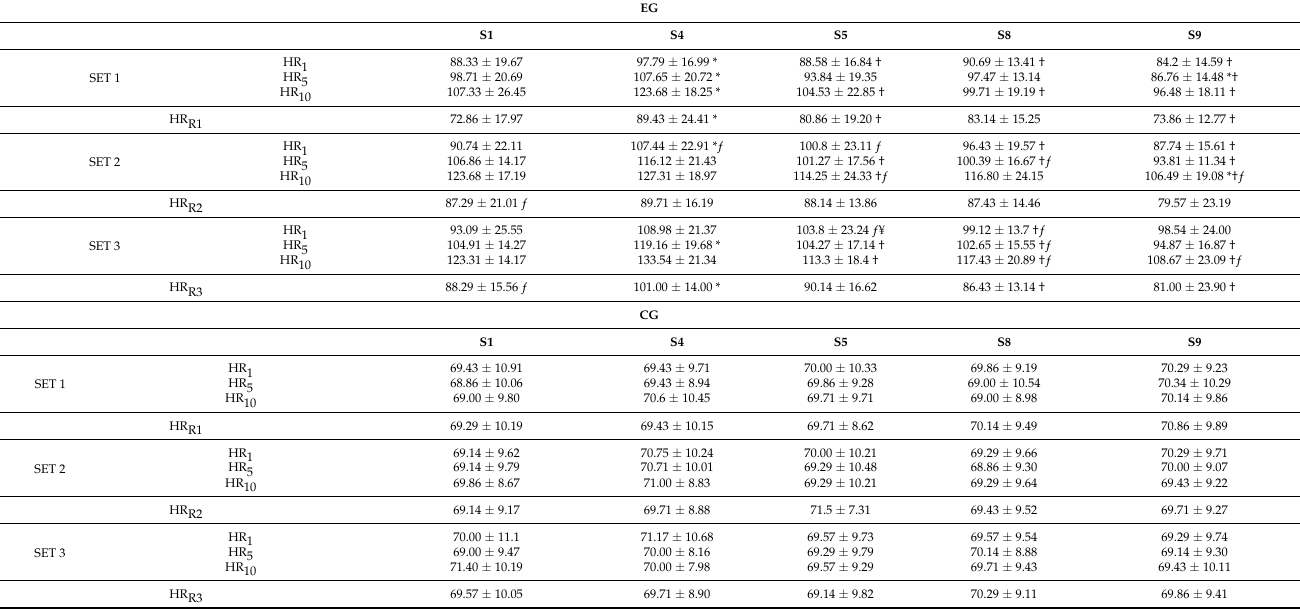
Figure 1. This figure describes Tcore and Tskin in each session in both groups. B = Before; A = After. The results of HR obtained from EG are expressed below in Table 3, and the CG re- sults are presented in Table 3. Table 3. HR of EG and CG in S1, S4, S5, S8, and S9.